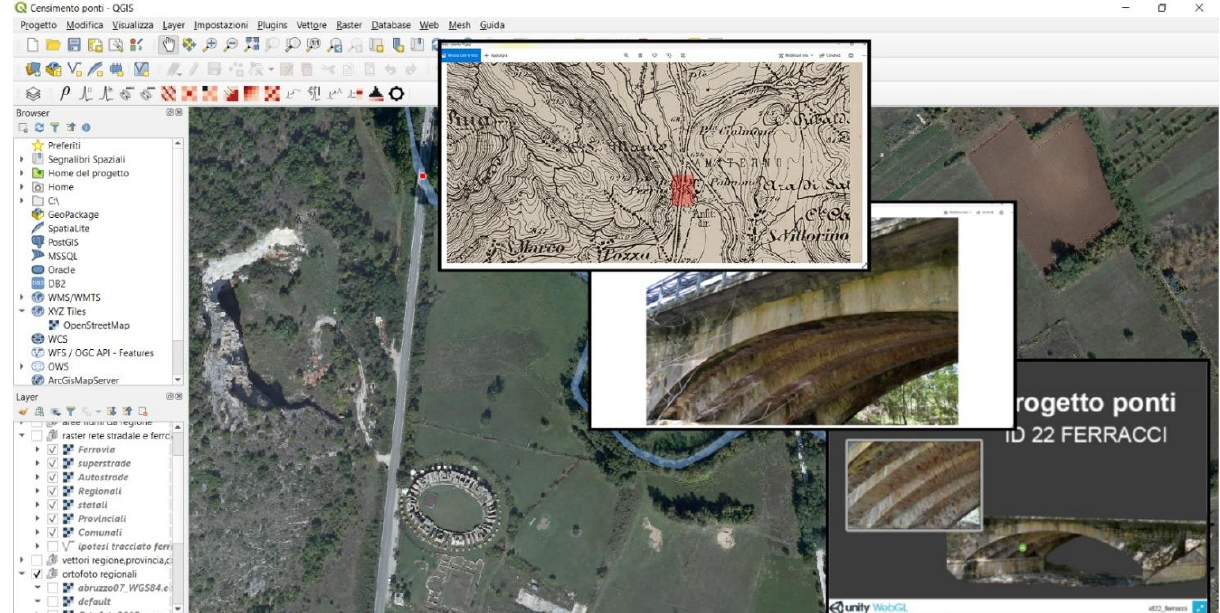
Figure 4. Screenshot of the QGIS project with external links (photo, historical cartography and three-dimensional model in WebGL).